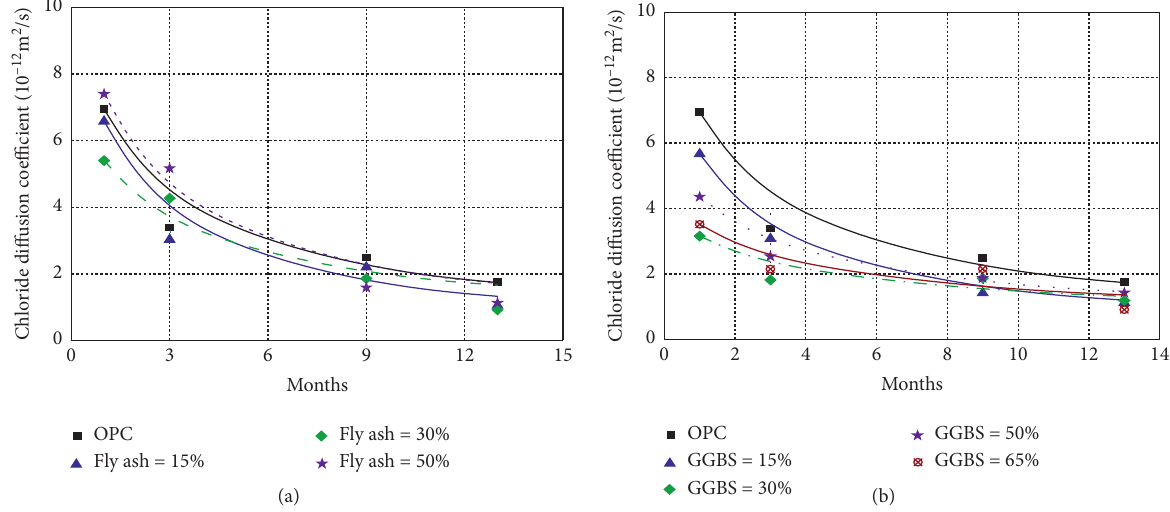
Figure 4: RCM test result of concrete. (a) With fly ash. (b) With